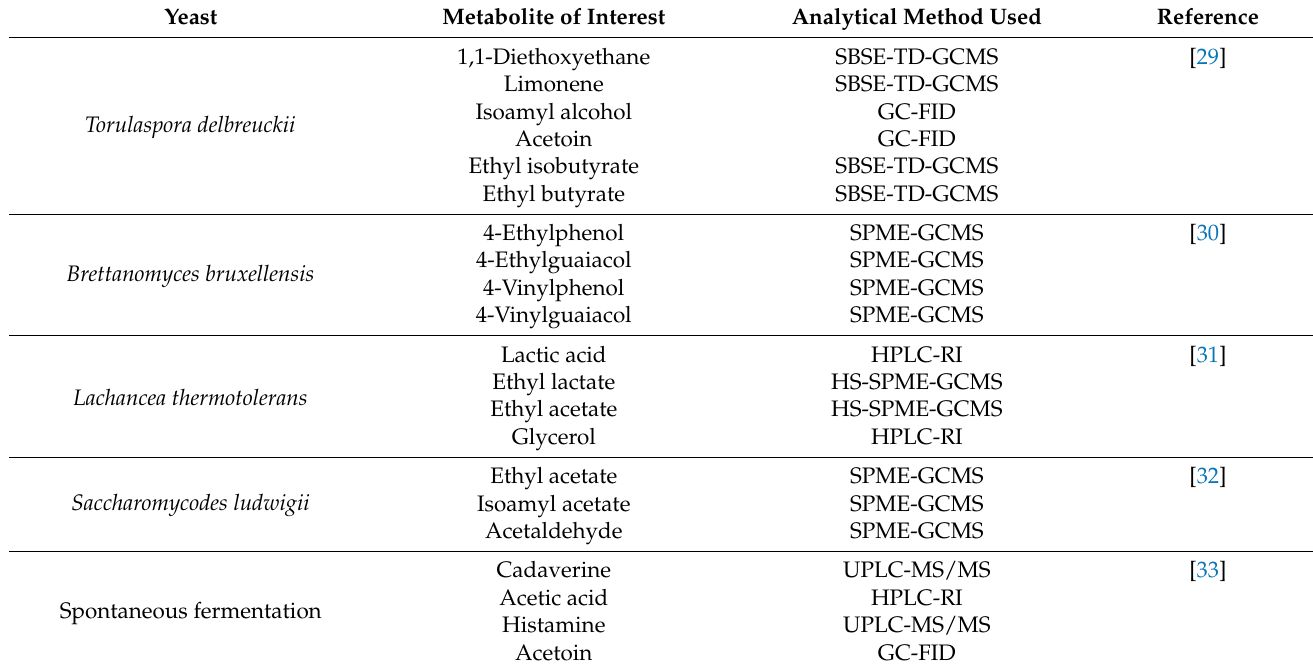
Figure 2. Typical workflows for metabolomic analysis of fermented beverages. Key steps include sample preparation, chromatographic separation, mass spectrometry, and data analysis based on database entries or pure standards. Table 1. Analytical methods suitable for analysis of important metabolites produced by non- Saccharomyces